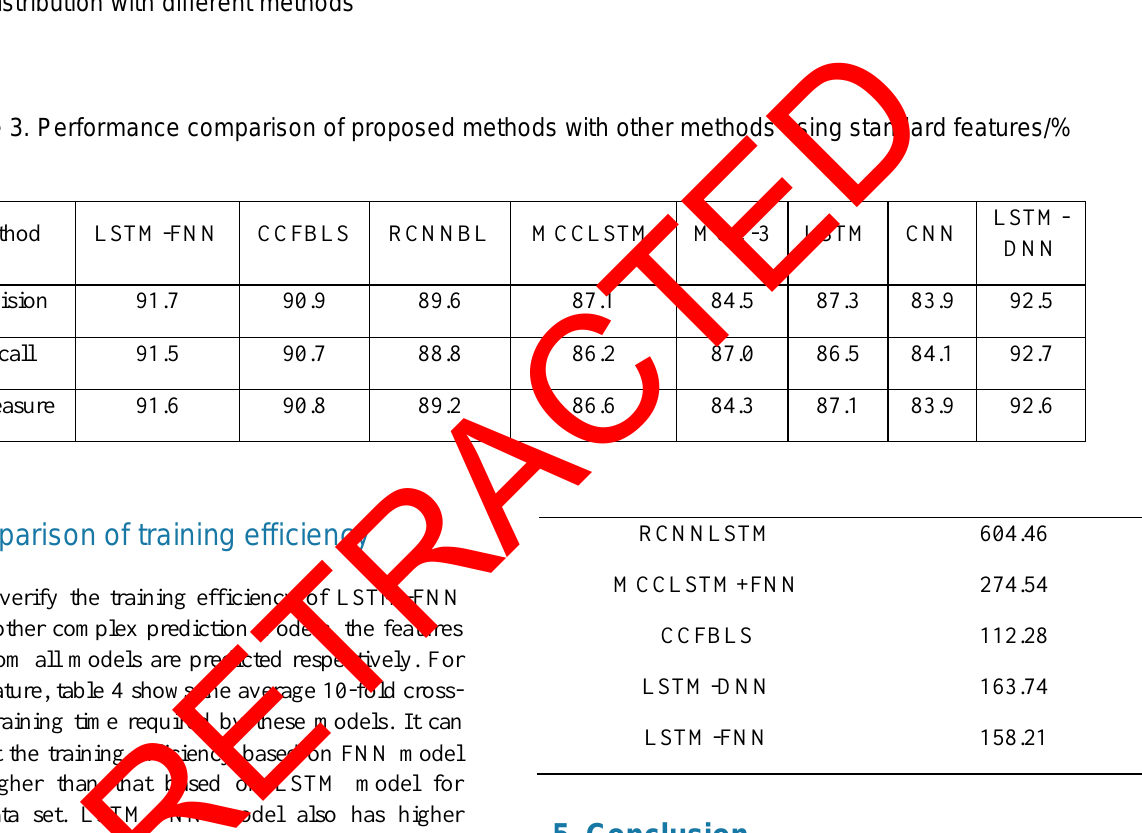
Figure 5. classification accuracy comparison distribution with different methods